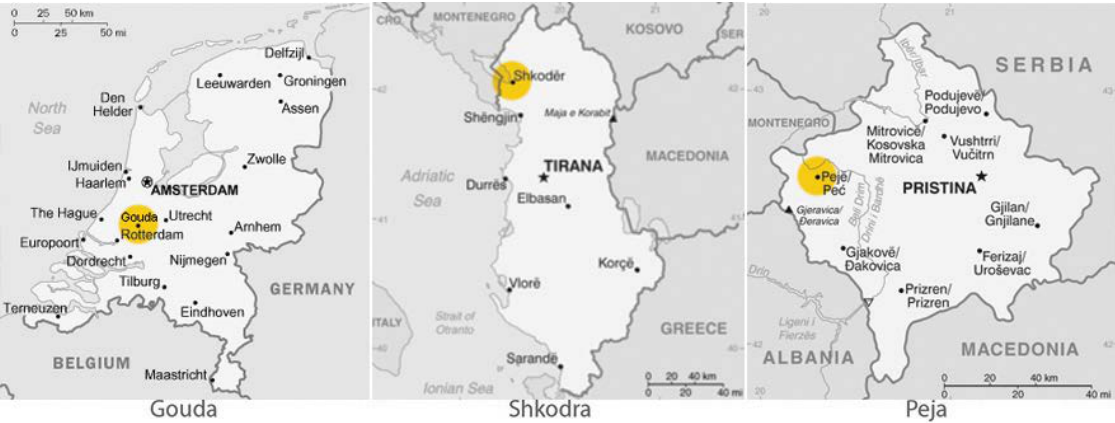
Figure 2. Location of the three case study